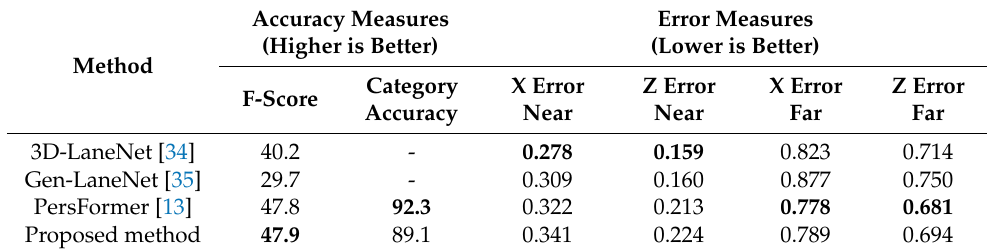
Table 2. The comparison results in both accuracy and error values.